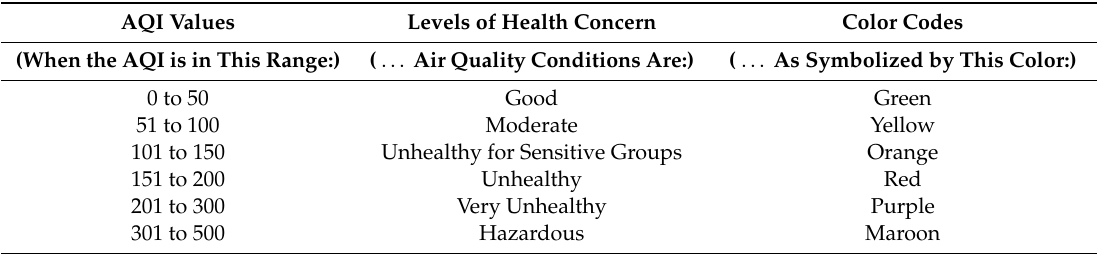
Table 3. Classifications of Air Quality Index. AQI Values Levels of Health Concern Color